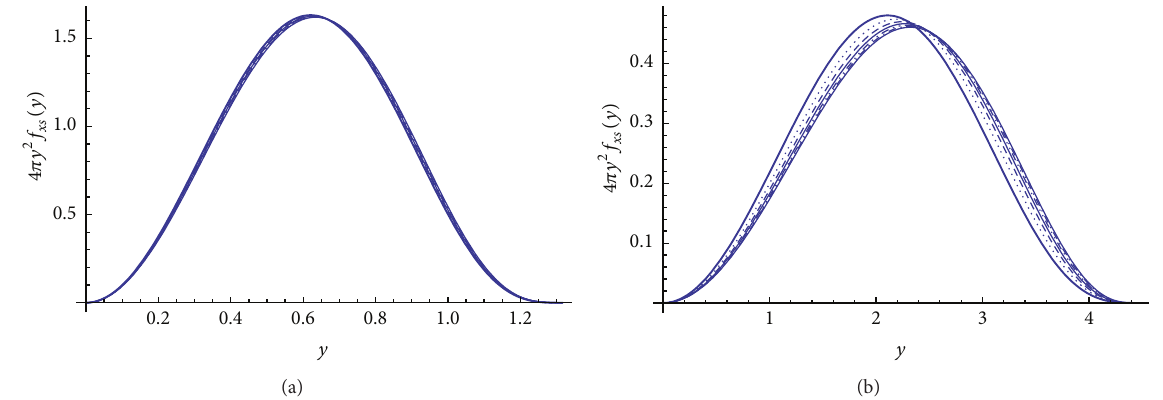
Figure 1: We show the properly normalized velocity distribution obtained in our simple model for various values of 𝑎 for the value 𝜉(𝑥𝑠) = √3/2 (a) and a larger, perhaps more realistic, value 𝜉(𝑥𝑠) = 10 (b). The obtained velocity distribution depends mildly on 𝑎 .